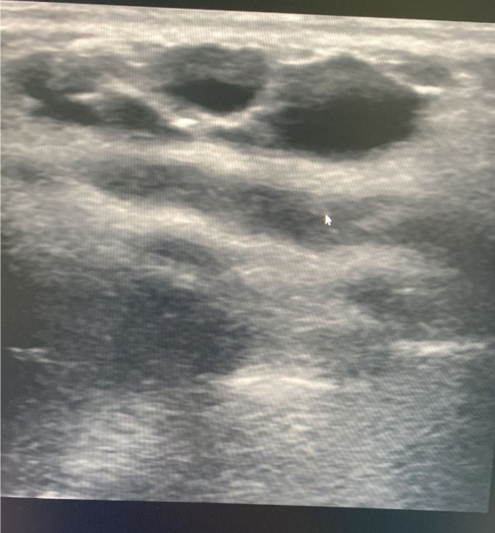
Figure 3. Transverse grey-scale ultrasound image shows an anechoic multilocular cystic lesion in the left lateral chest